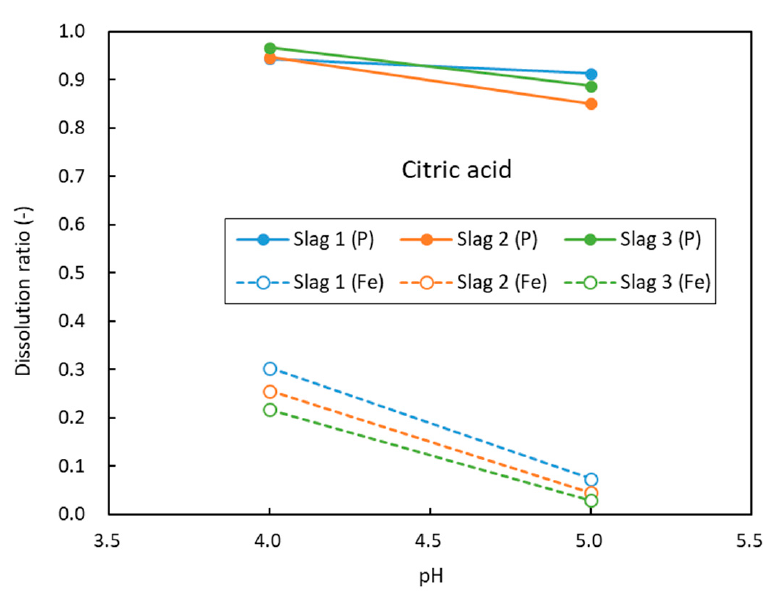
Figure 6. Dissolution ratio of each element from dephosphorization slag in citric acid solution at various pH conditions.